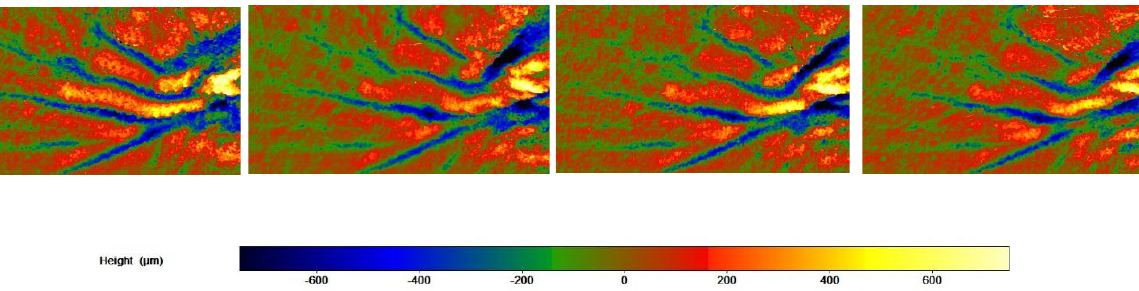
Figure 7. Skin profilometry of a G3 subject throughout the study period. Image size: 21 h × 38 w.